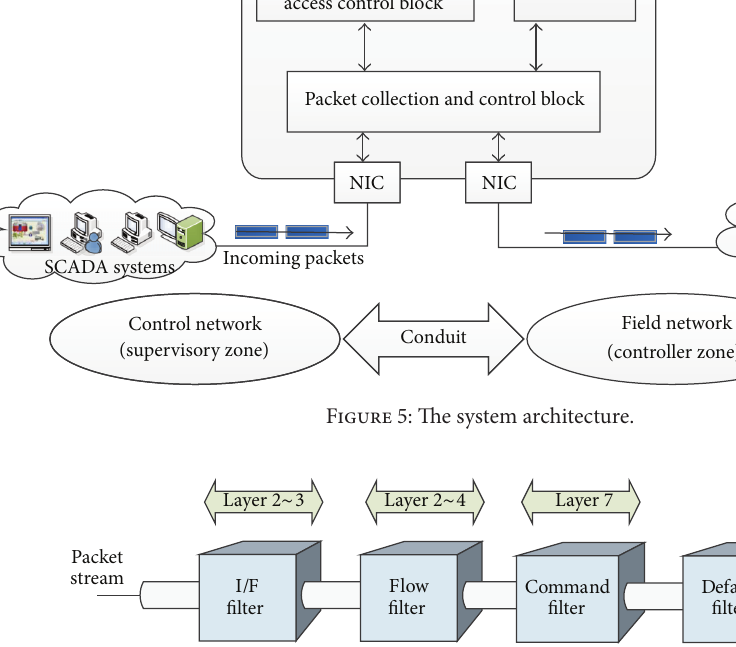
Figure 6: The process of multiple